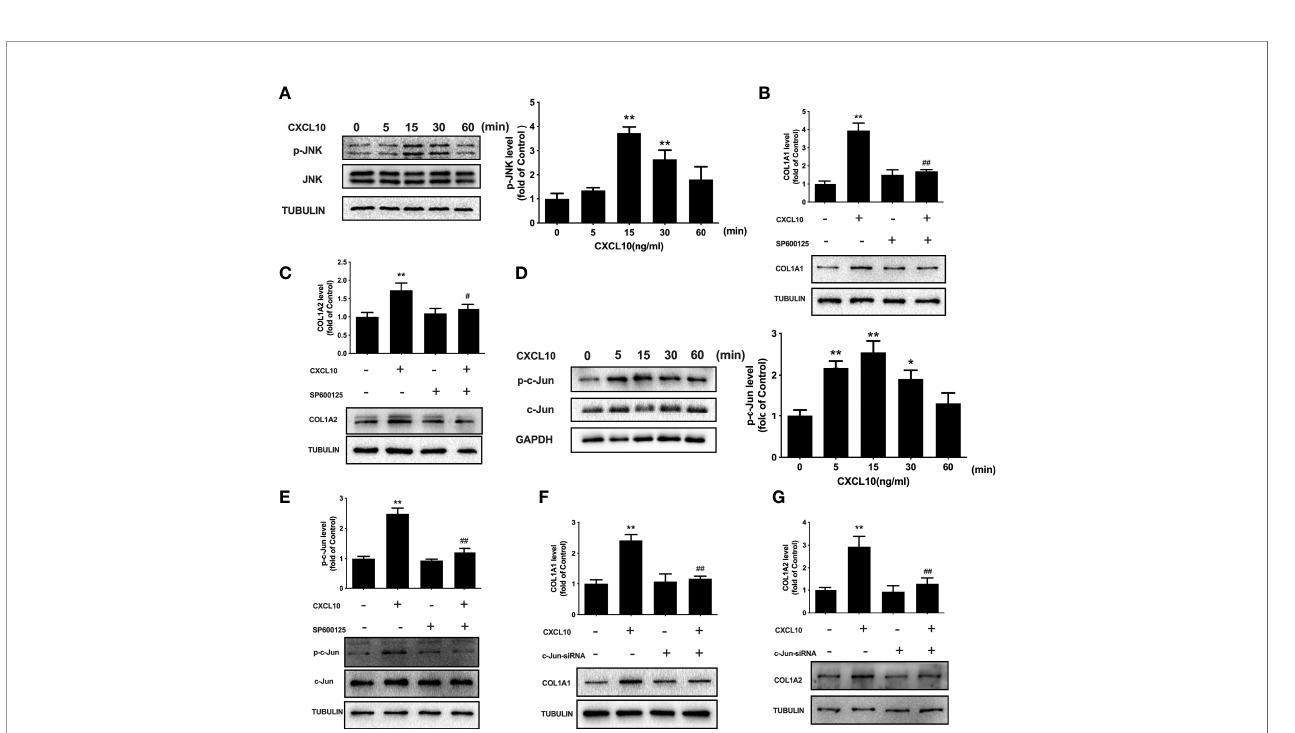
FIGURE 7 | Involvement of JNK and c-Jun in the regulation of collagen I by CXCL10 in ovarian theca – stroma cells. (A) Time course effects of CXCL10 (10 ng/ml) on the phosphorylation of JNK in ovarian theca – stroma cells. (B, C) Effects of CXCL10 (10 ng/ml, 24 h) on the protein levels of COL1A1 and COL1A2 in the presence or absence of inhibitors for JNK (SP600125, 10 m M). (D) Time course effects of CXCL10 (10 ng/ml) on the phosphorylation of c-Jun in ovarian theca – stroma cells. (E) Effects of CXCL10 (10 ng/ml, 15 min) on the phosphorylation of c-Jun in the presence or absence of inhibitors for JNK (SP600125, 10 m M). (F, G) Effect of CXCL10 (10 ng/ml, 24 h) on COL1A1 and COL1A2 protein levels in the presence or absence of siRNA-mediated knockdown of c-Jun. n = 3. * P < 0.05, ** P < 0.01 vs. control; # P < 0.05, ## P < 0.01 vs.